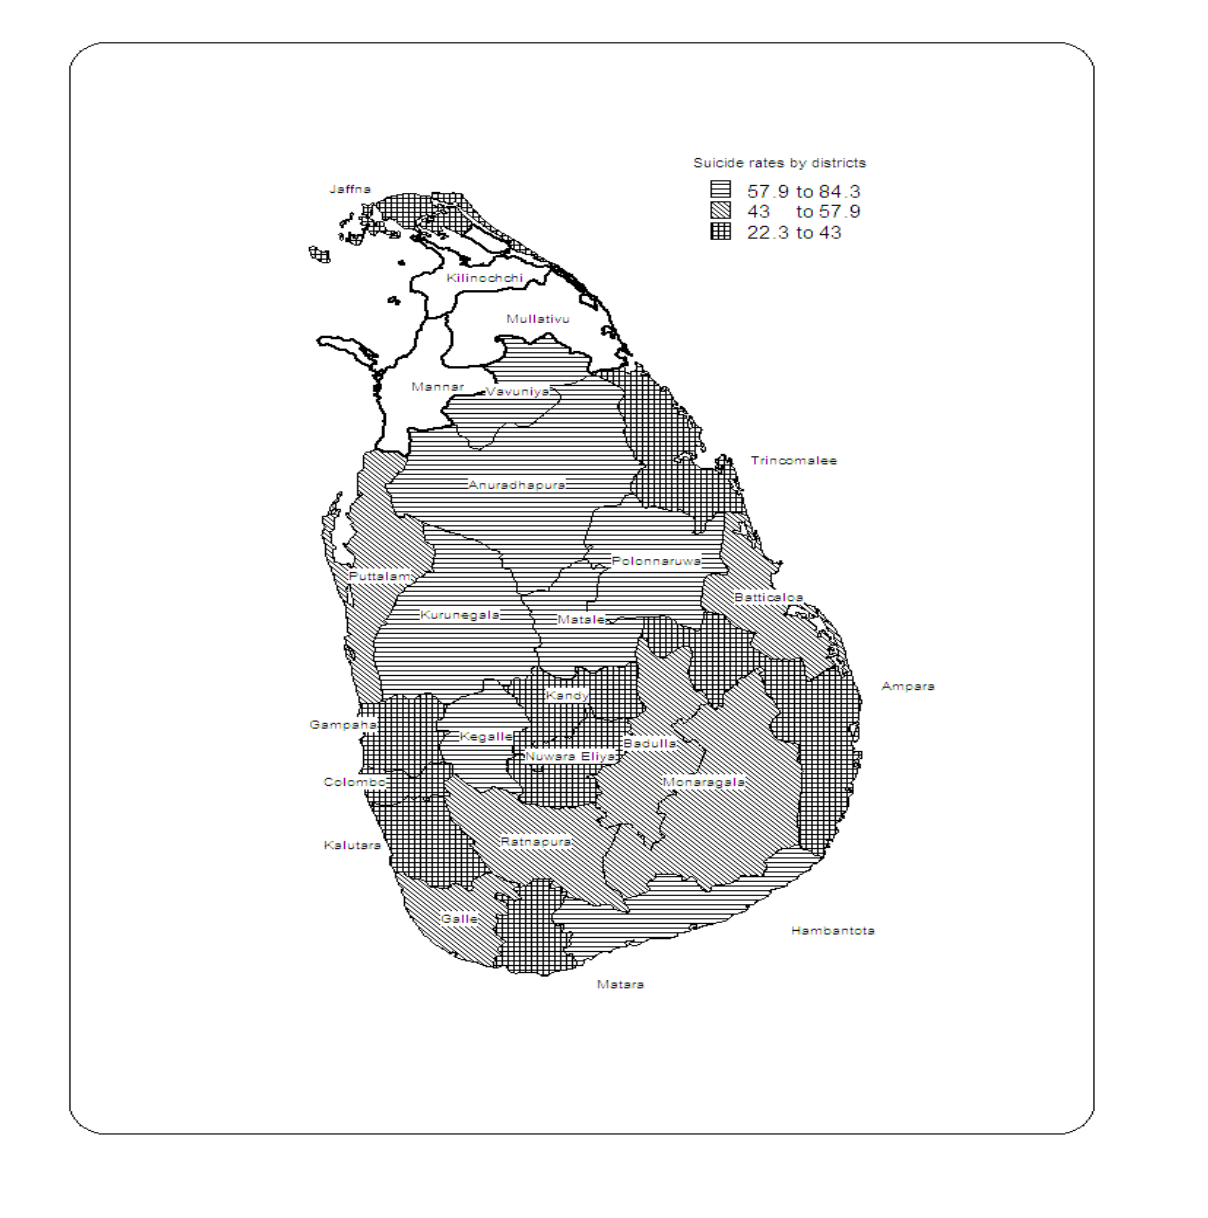
Figure 7 Average suicide rates by districts -1997 to